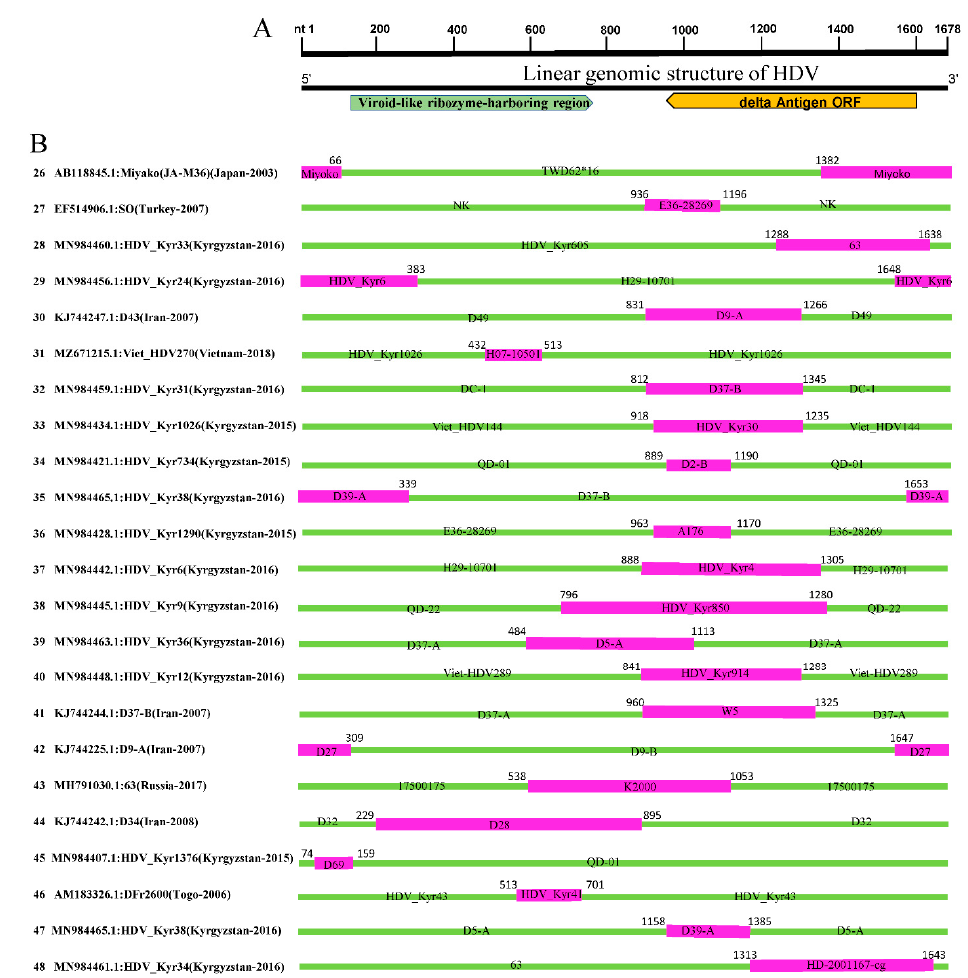
Figure 4. Recombination map across the human HDV genomes for recombination events 26–48. ( A ) Linear genomic structure of HDV full-length sequences (1678 nt). ( B ) Diagram indicating natural recombination events 26–48 detected using the RDP4 software. The numbers on the left indicate the serial number of recombination events. Regions of the major and minor parental sequences are indicated by the green and pink blocks, respectively. Numbers on the top of the blocks indicate the nucleotide positions of breakpoints relative to the full-length genome sequence of the corresponding recombinant viruses.